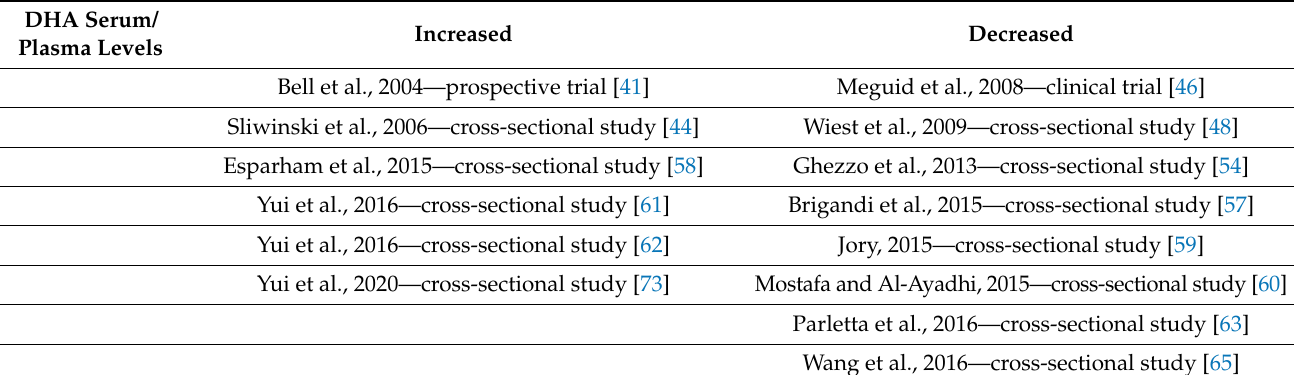
Table 4. Associations between docosahexaenoic acid (DHA) serum/plasma levels and Autism spectrum disorders. DHA Serum/